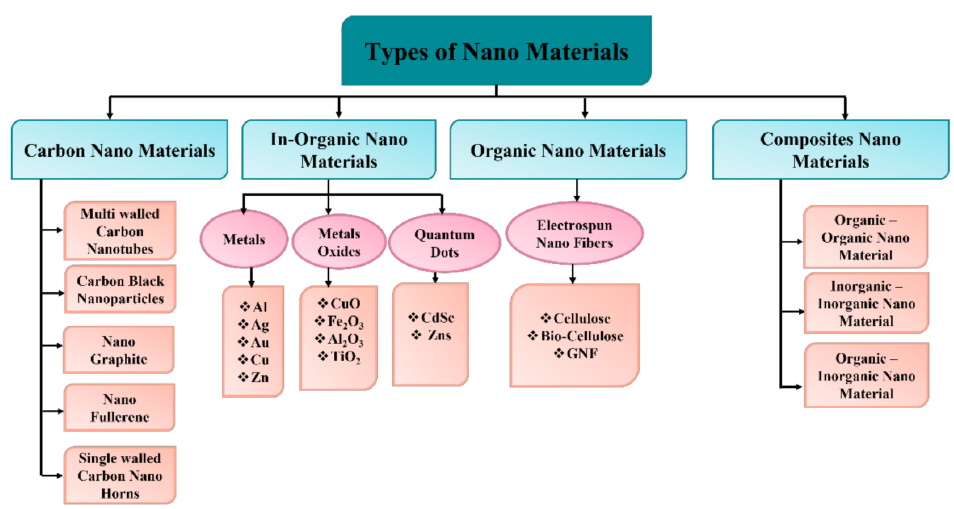
Figure 5. Classification of nanomaterials